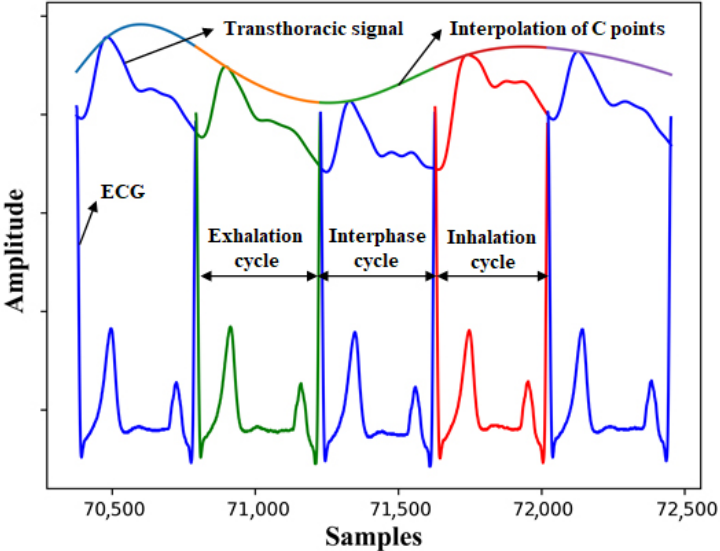
Figure 3. Dividing signals intervals within inhalation, exhalation, or in interphase based on ECG and trancthoracic signals.